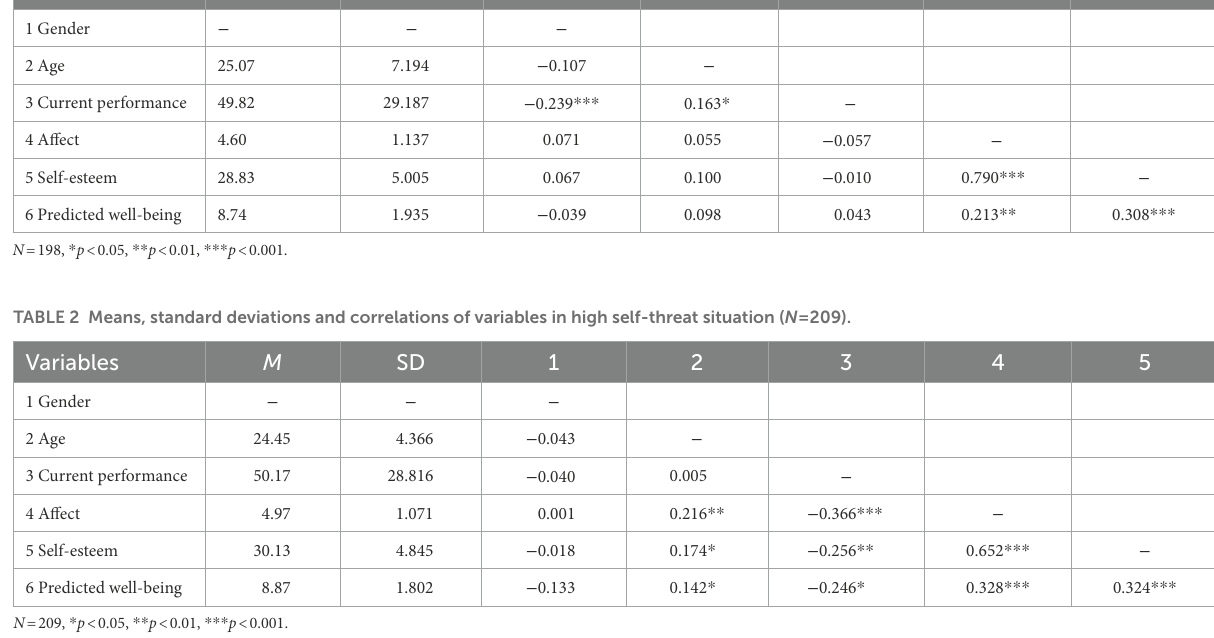
TABLE 1 Means, standard deviations and correlations of variables in low self-threat situation ( N = 198). Variables